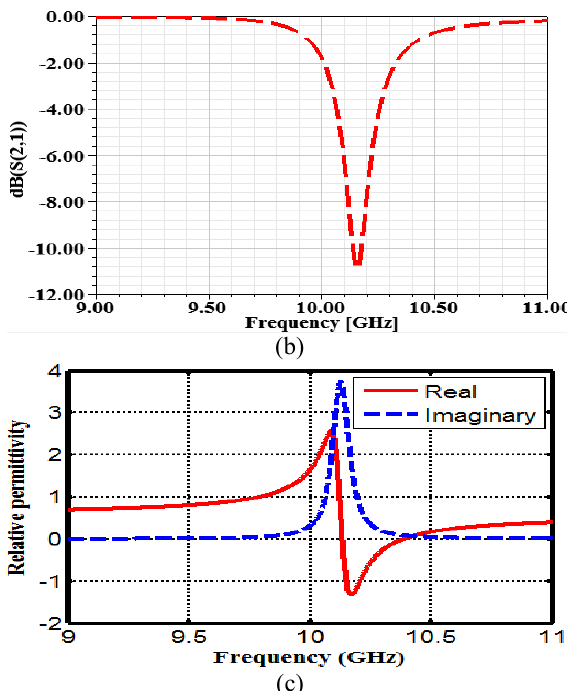
Figure 3: (a) Rectangular CSRR unit cell, (b) Simulated S- parameters of CSRR unit cell. (c) Extracted permittivity of the CSRR unit cell.